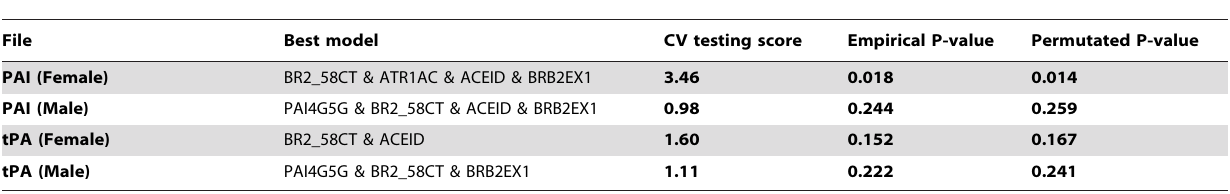
Table 3. Best overall model identified by